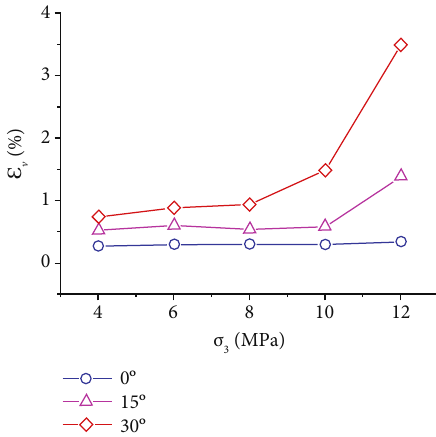
Figure 11: Volume strain ε ff erent